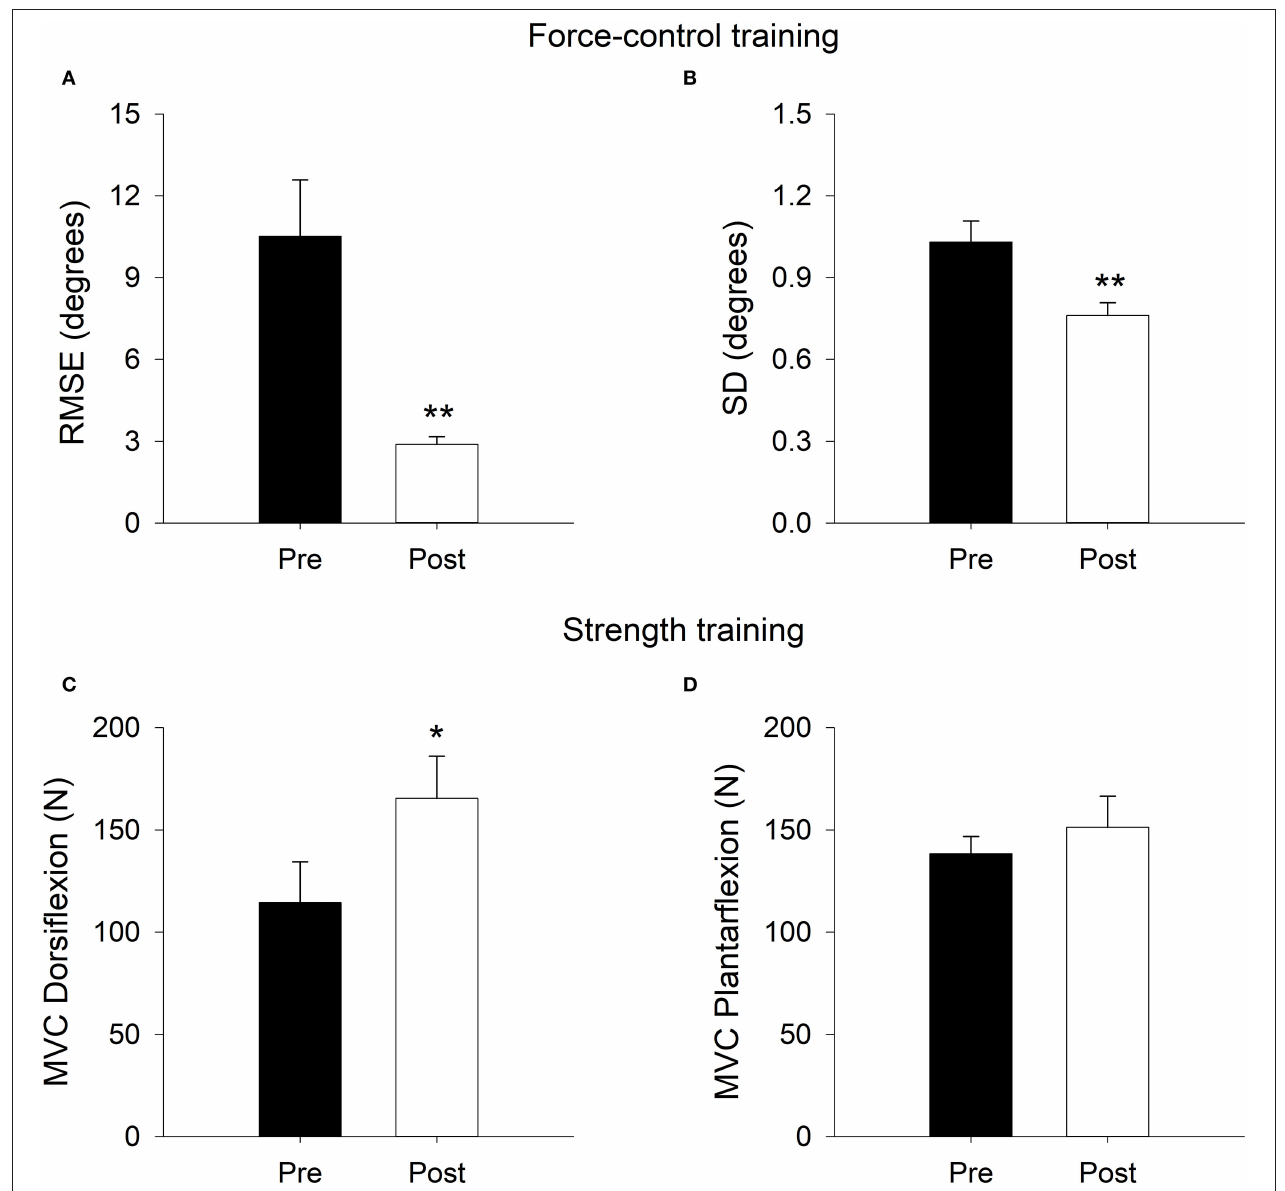
FIGURE 3 | Task-specific training effects on ankle movement error (Root mean square error, RMSE; A ) and ankle movement steadiness (standard deviation, SD; B ) in the force-control training group. Task-specific training effects on dorsiflexion strength (maximum voluntary contraction; MVC; C ) and plantarflexion strength (D) in the strength training group. The ankle movement accuracy and steadiness improved after force-control training. The ankle dorsiflexion strength improved after strength training. ** p < 0.01; * p <